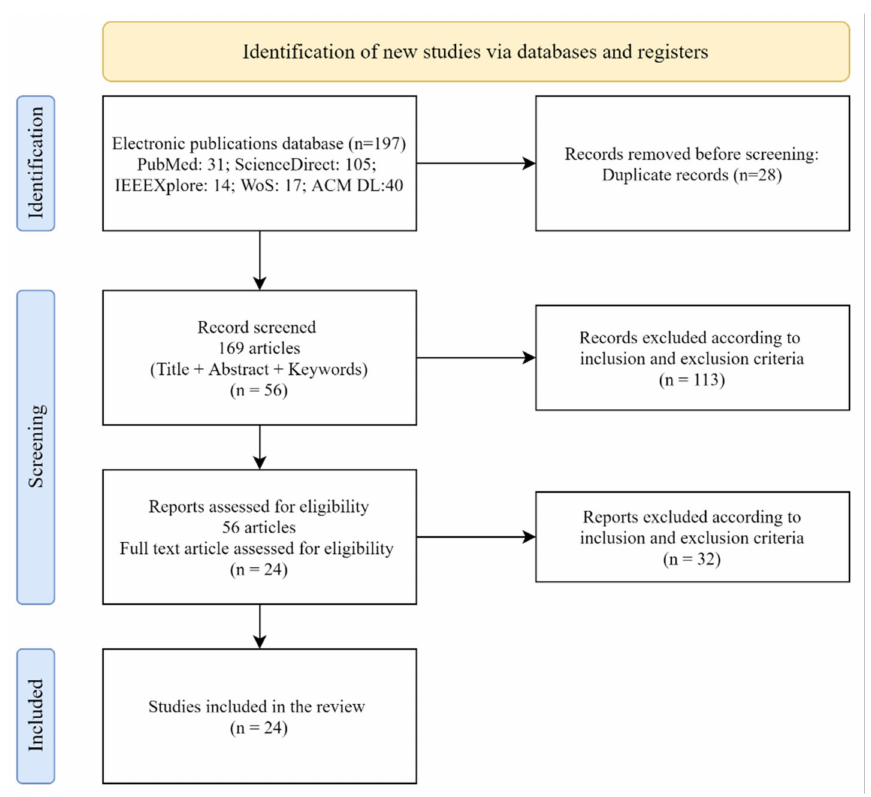
Figure 2. Study selection using PRISMA flow diagram method consisting of identification step, screening step, and included